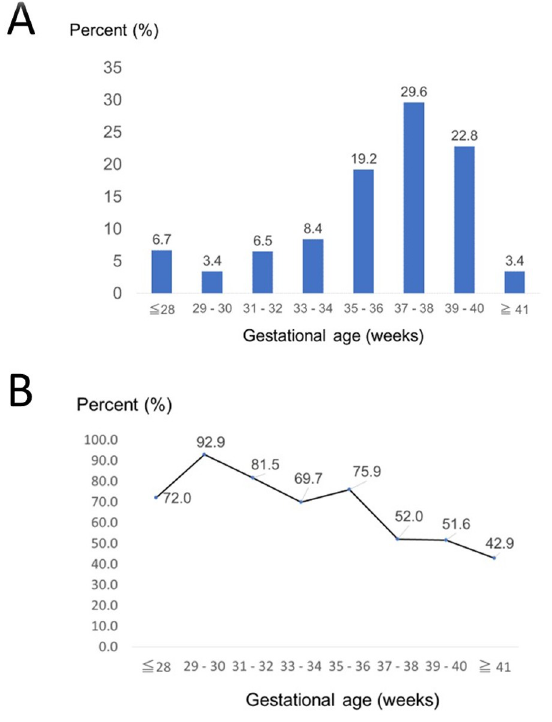
Fig 2. (A) The prevalence of placental abruption stratified by gestational age. (B) The rate of cesarean section among women with placental abruption stratified by gestational